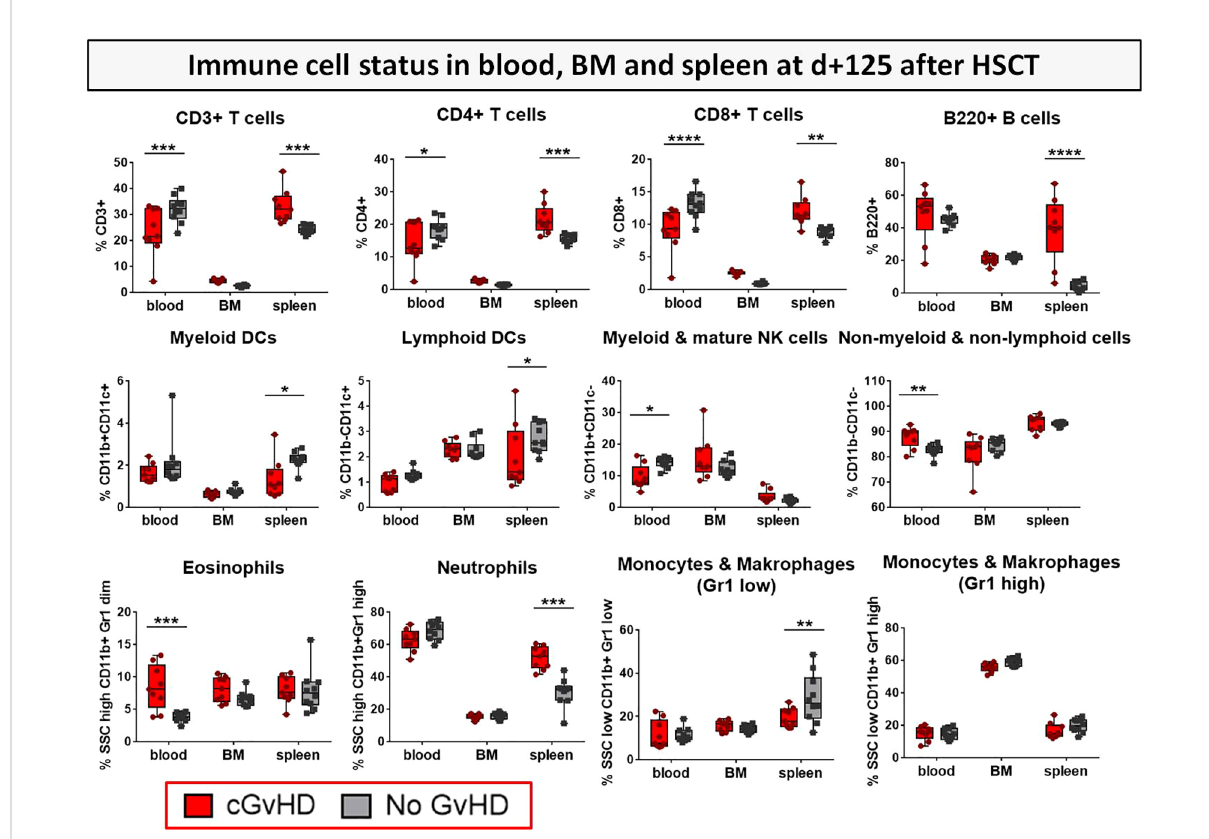
FIGURE 9 Immune cell status in peripheral blood, bone marrow and spleen of BDF1-recipients at day +125 after allo- vs. syn HCT. Blood was collected retrooribitally upon fi nalization. Spleens were harvested and BM fl ushed from tibia and femur. Immune cells were isolated, stained with the respective FACS-antibodies and samples were analyzed with fl ow cytometry DCs, dendritic cells; NK, natural killer cells; dim, diminished.n=9 (cGvHD); n=10 (No GvHD). Representative data from one out of four experiments. *P<0.05, **P<0.01, ***P<0.001, ****P<0.0001 by unpaired students